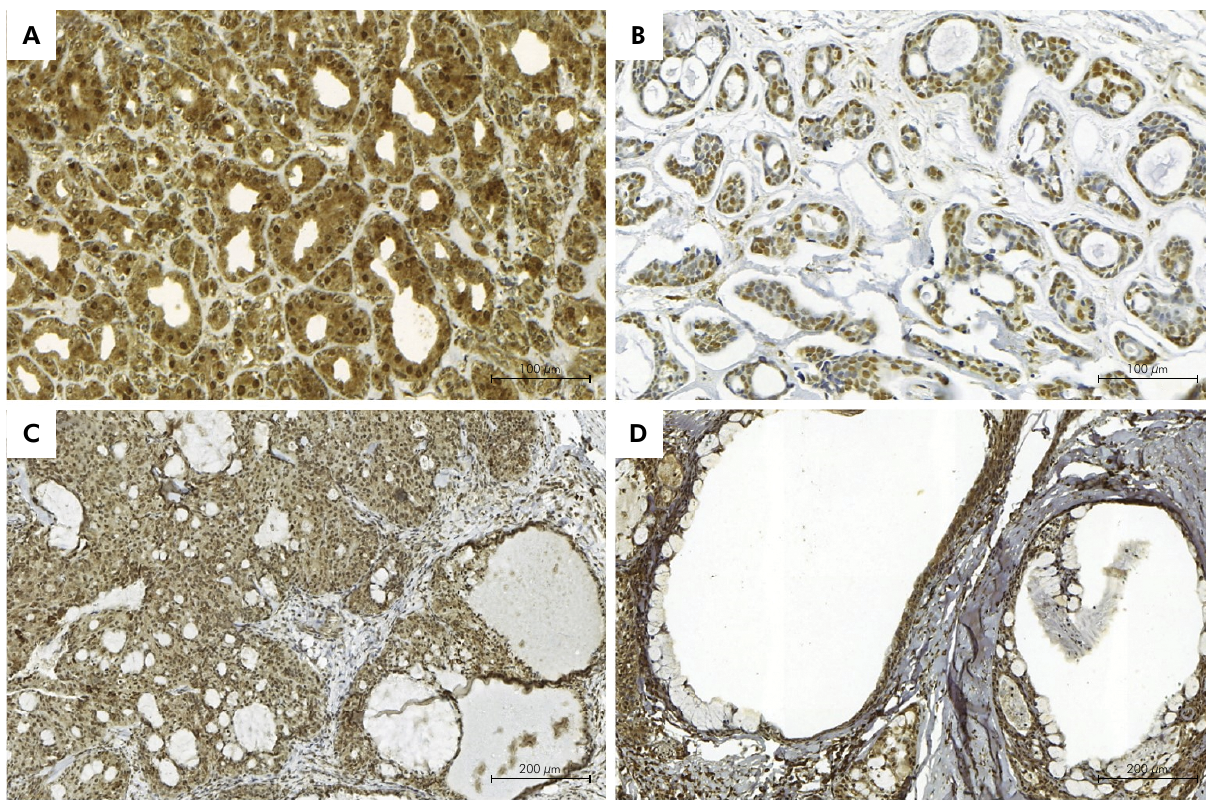
Figure 1. Immunohistochemical reactivity for OCT4 in PA (A), CAC (B), and MEC (C) and absence of expression of OCT4 in mucous cells of MEC (D). Panoramic Viewer,